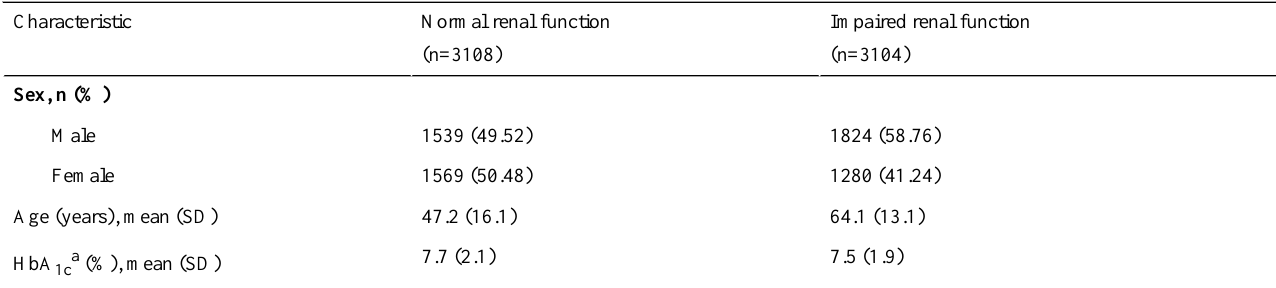
Table 2. Clinical information of patients with normal or impaired renal function (N=6212); all P values are <.001.